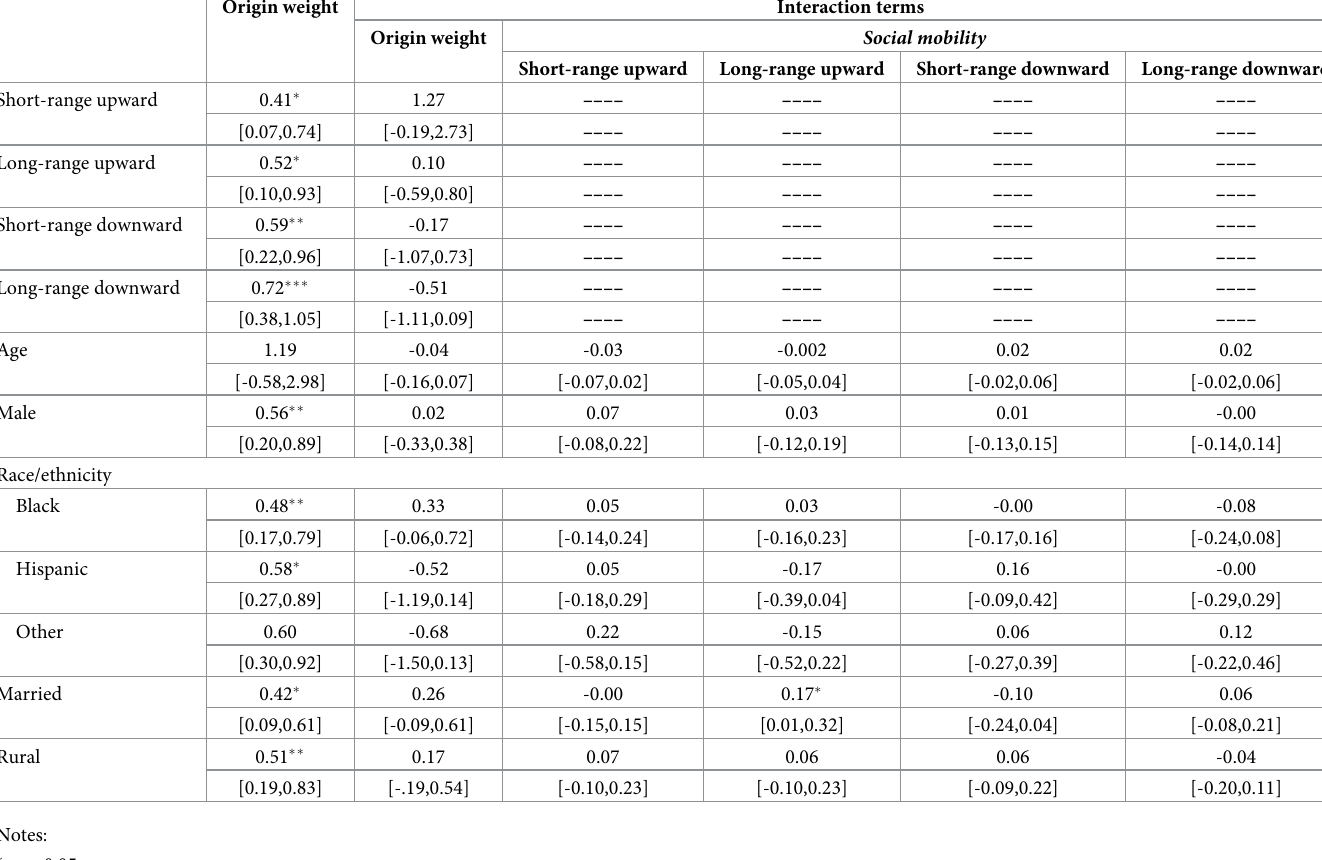
Table 4. Origin weights and point estimates for interaction terms from DRM on AL